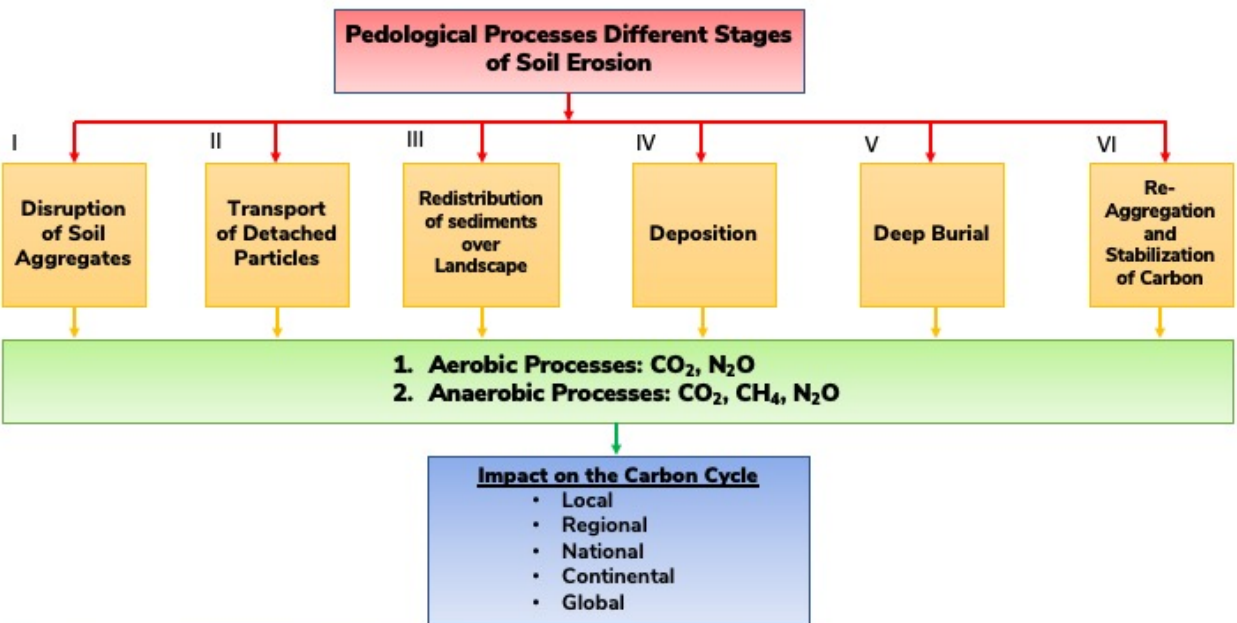
Figure 1. Fate of carbon transported by erosional processes at different stages.